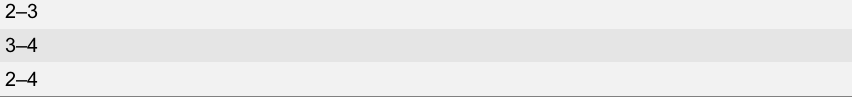
Table 2. Example of connections for a study carried out in country 2, 3, and 4.